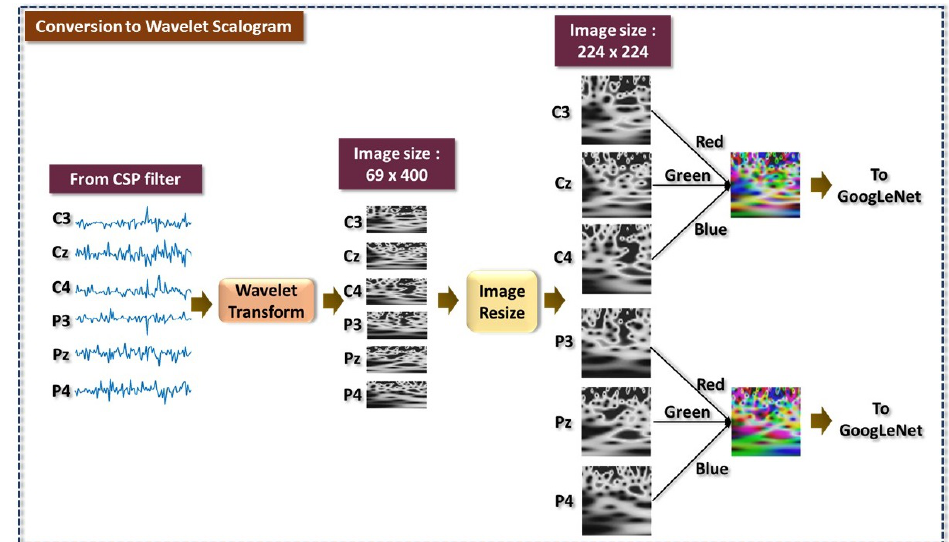
Figure 4. Formation of scalogram images of EEG motor function from electrode C3, Cz, C4, P3, Pz and P4 using